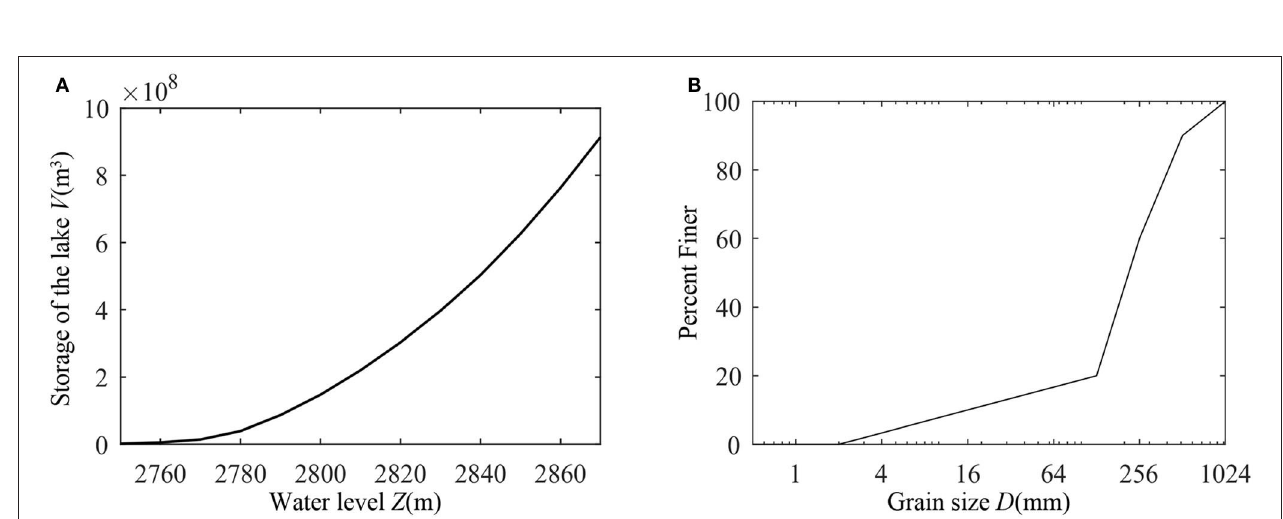
FIGURE 3 | Calculation conditions for the breach simulation of the Jiala barrier dam. (A) The level-storage curve of the Jiala barrier lake; (B) GSD of dam material adopted in the emergency simulation of the Jiala barrier dam and Baige barrier dam.